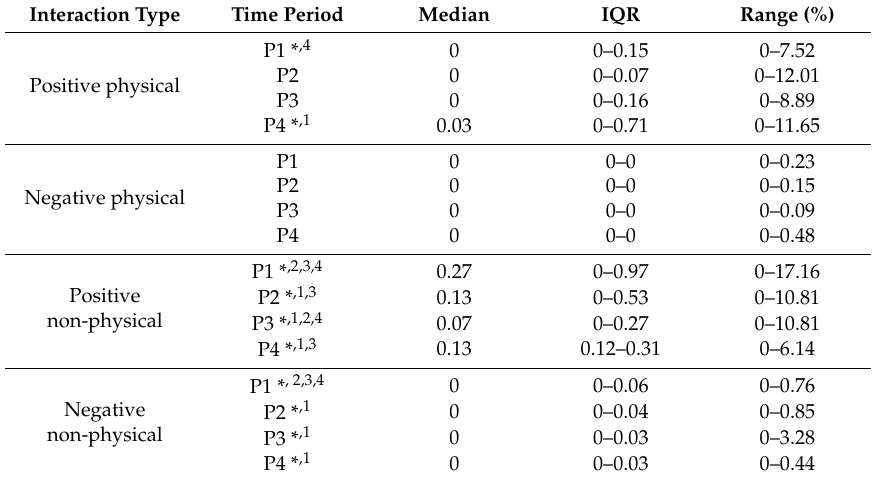
Table 5. Median recorded frequencies of social interactions given within elephant dyads.